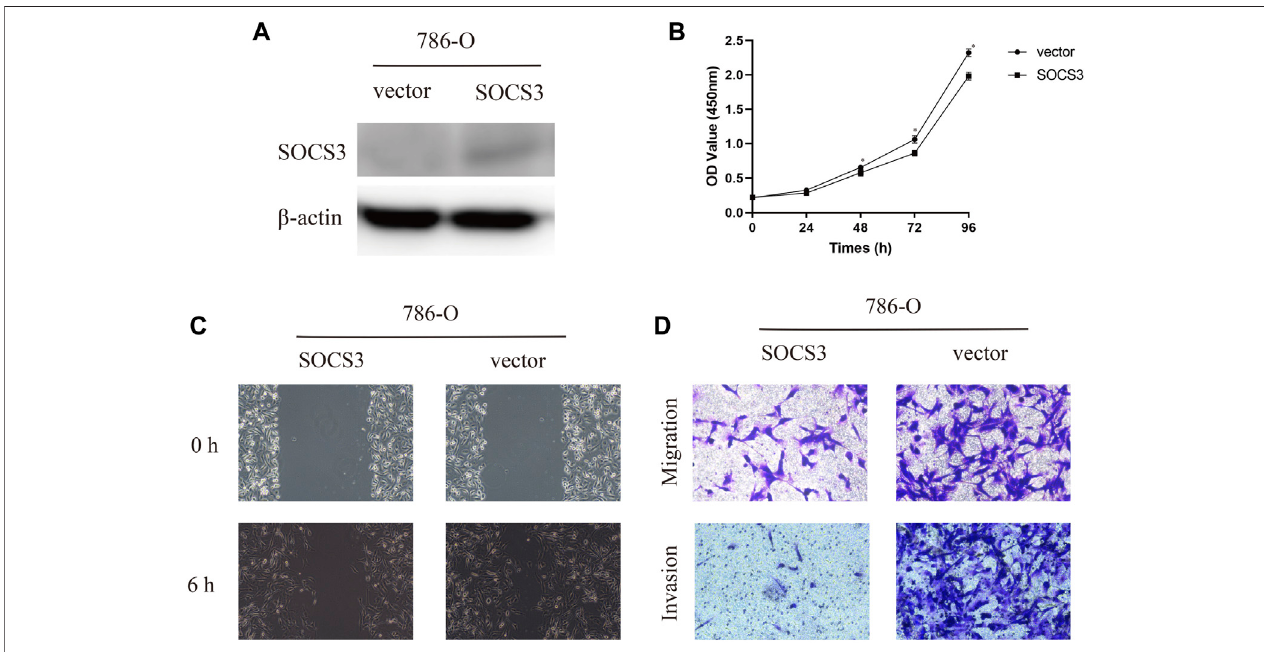
FIGURE 3 | Overexpression of SOCS3 inhibited proliferation, migration, and invasion. (A) Western blot revealed that SOCS3 overexpression plasmids lead to an upregulation of SOCS3. (B) SOCS3 inhibited cell proliferation by CCK-8 assay. (C) Wound healing assay showed that overexpression of SOCS3 inhibited a closing of scratch wounds. (D) Overexpression of SOCS3 inhibited cell migration and